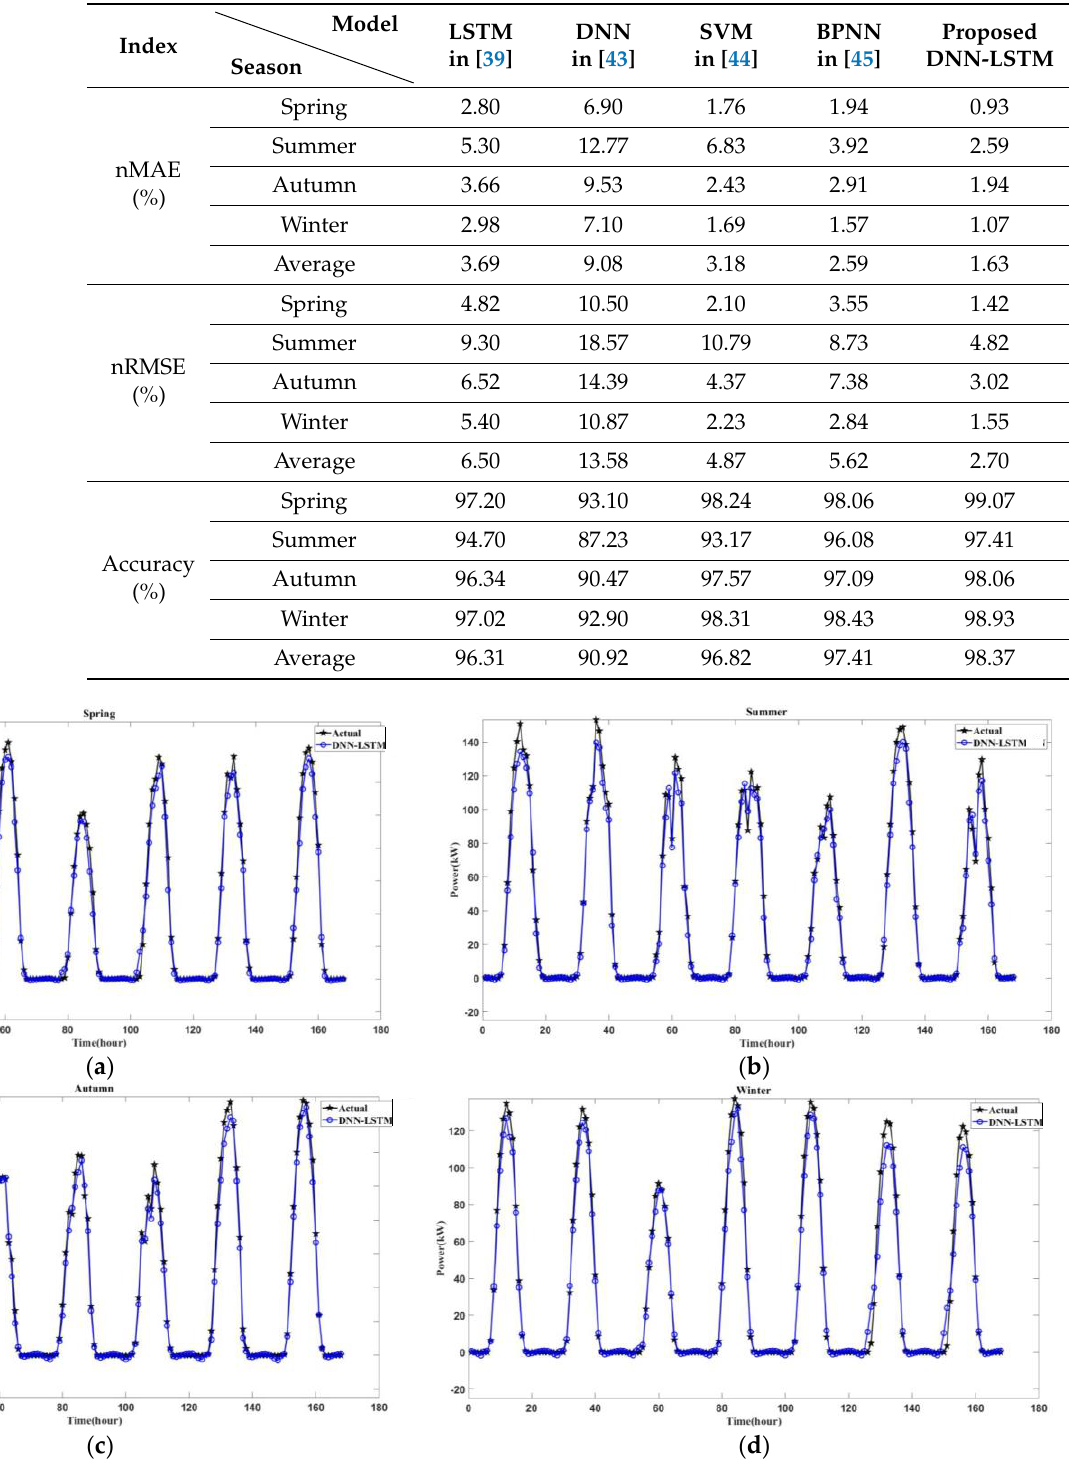
Table 5. Comparisons of performance indicators of five forecasting models for solar power plant A.